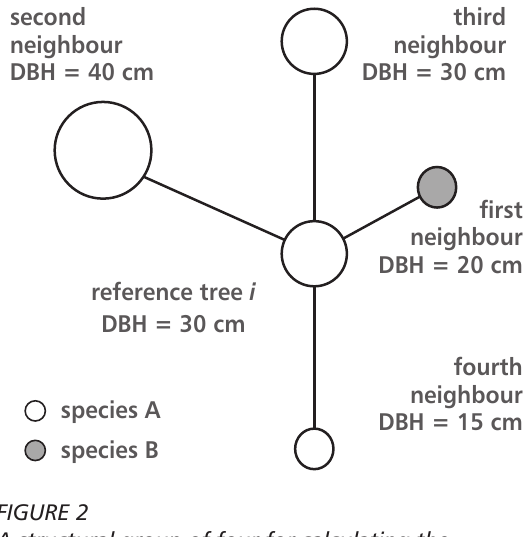
A structural group of four for calculating the species mingling and the DBH differentiation index (Pommerening [15] modified after Albert and Gadow [15]. When at least three nearest neighbouring trees are selected, four possible results may be assumed (0.00; 0.33; 0.67; 1.00). With four neighbours, there are five possible results (0.00; 0.25; 0.50; 0.75; 1.00). The overall mingling index for the stand (sample plot) is defined by the average value of all reference trees. The bigger the mean mingling, the more different tree species are intermingled. Lower values are pointing to segregation [18].